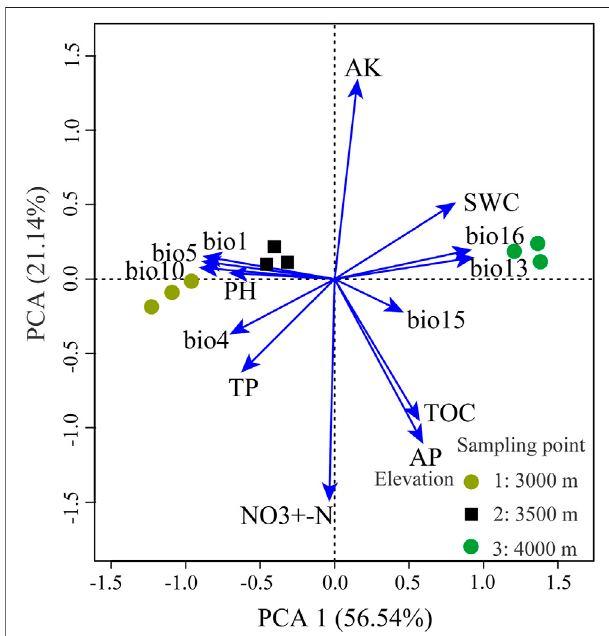
FIGURE 2 | Results of the principal components analysis (PCA) examining the distribution of environment variables across the experimental site. Arrows indicate directions of loading for each variable. NO 3+ -N, soil nitrate-nitrogen; AP, soil available phosphorus; AK, soil available potassium; pH, pH of the soil in 1:2.5 (mass:volume), TP, soil total phosphorus, SWC, soil water content, TOC, soil total organic carbon. bio1, annual mean temperature; bio4, temperature seasonality; bio5, the max temperature of the warmest month; bio10, mean temperature of the warmest quarter; bio13, precipitation of the wettest month; bio15, precipitation seasonality; bio16, precipitation of wettest quarter.